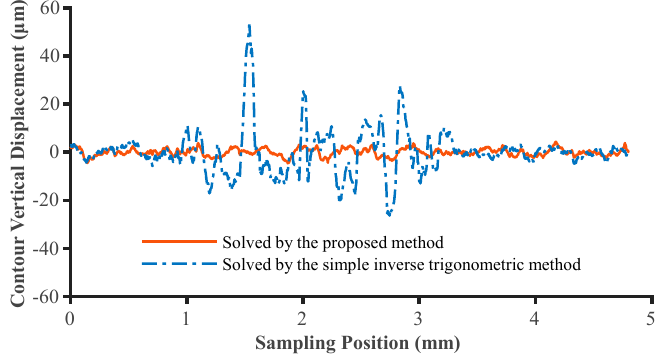
Figure 12. The evaluation curves of the roughness near the singularity point. Table 4. The roughness results near the singularity point.